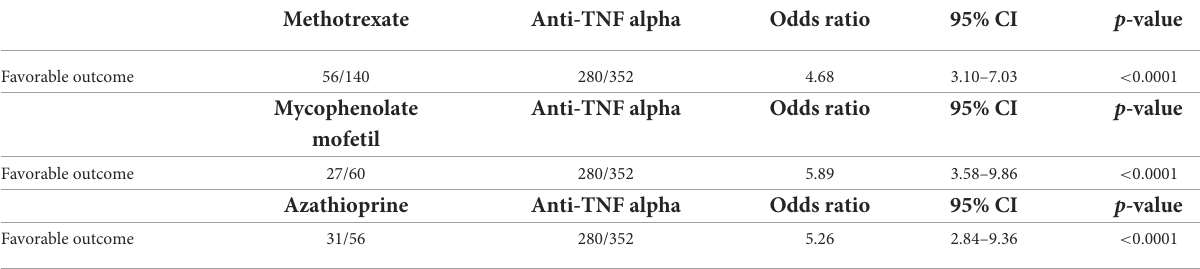
TABLE 8 Comparison of treatment outcomes of neurosarcoidosis according to treatment between azathioprine, methotrexate, and mycofenolate mofetil, respectively, and TNF-alpha